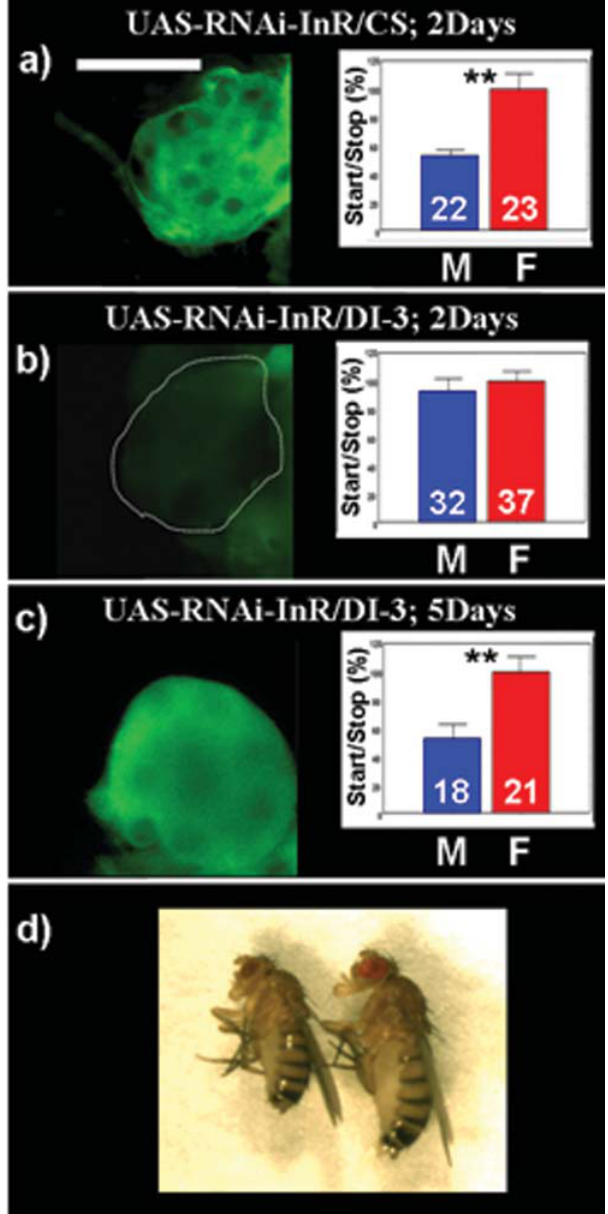
Figure 6. Directed expression of p[UAS-RNAi-InR] specifically in the corpus allatum, mimics the hmgcr mutation. For all panels (a–c): immunostaining using a primary antibody raised against the human form of the InR, revealed by a secondary antibody labeled with FITC (green). a–c) Targeting the UAS-RNAi-InR specifically in the ca blocks the InR expression and disrupts the sexual dimorphism. This effect is completely reversible. In 2 days old DI-3/UAS-RNAi-InR flies (b), InR is not detectable and the number of start/stop is identical between males and females compared to controls flies (a) (2 days old UAS-RNAi-InR/ CS). Interestingly, in 5 days old DI-3/UAS-RNAi-InR flies (c) the InR is detectable and the start/stop number is sexually dimorphic. This result corroborates the temporal expression pattern driven by the DI-3. Additionally, this strongly suggests, like for the RNAi-HMGCR, the reversibility of the RNAi-InR effect. N.B.: again here, results from b) and d) come from the same flies, recorded at 2 and 5 days old, respectively. d) Expressing the UAS-RNAi-InR in the ca under the control of DI-11 leads to a strong lethality when flies are reared at 24 u C and 19 u C. However, at 19 u C, few females survive, but they are dwarf (left: dwarf female DI-11/UAS-RNAi-InR, right: female control (UAS-RNAi-InR/CS). Scale bar=25 m